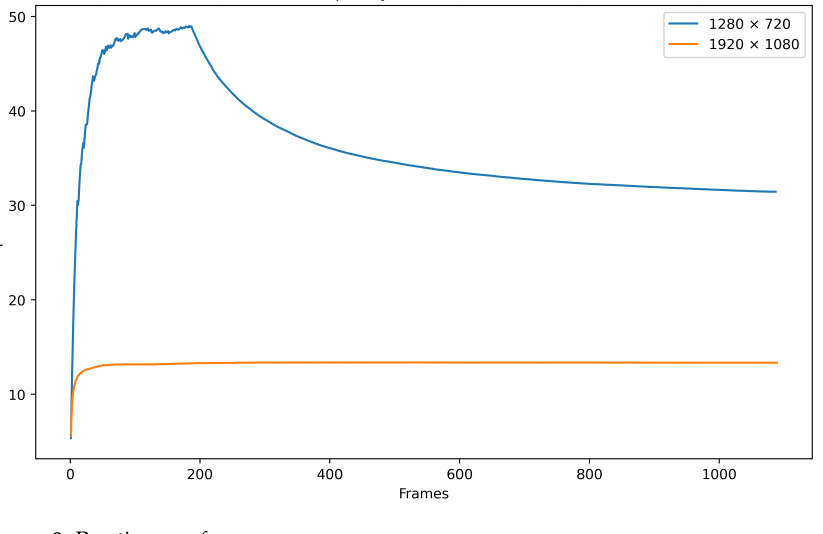
Figure 8. Runtime